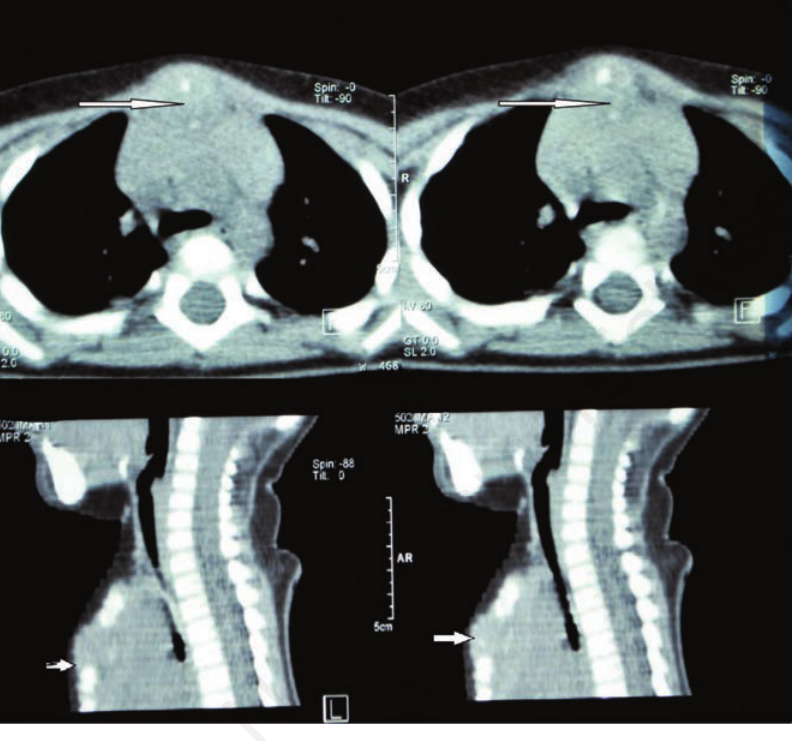
Figure 1. Computed tomography without contrast-enhanced axial and multi planar reconstruction sagittal images show the mass in the anterior mediastinum, around the manubrium of sternum.